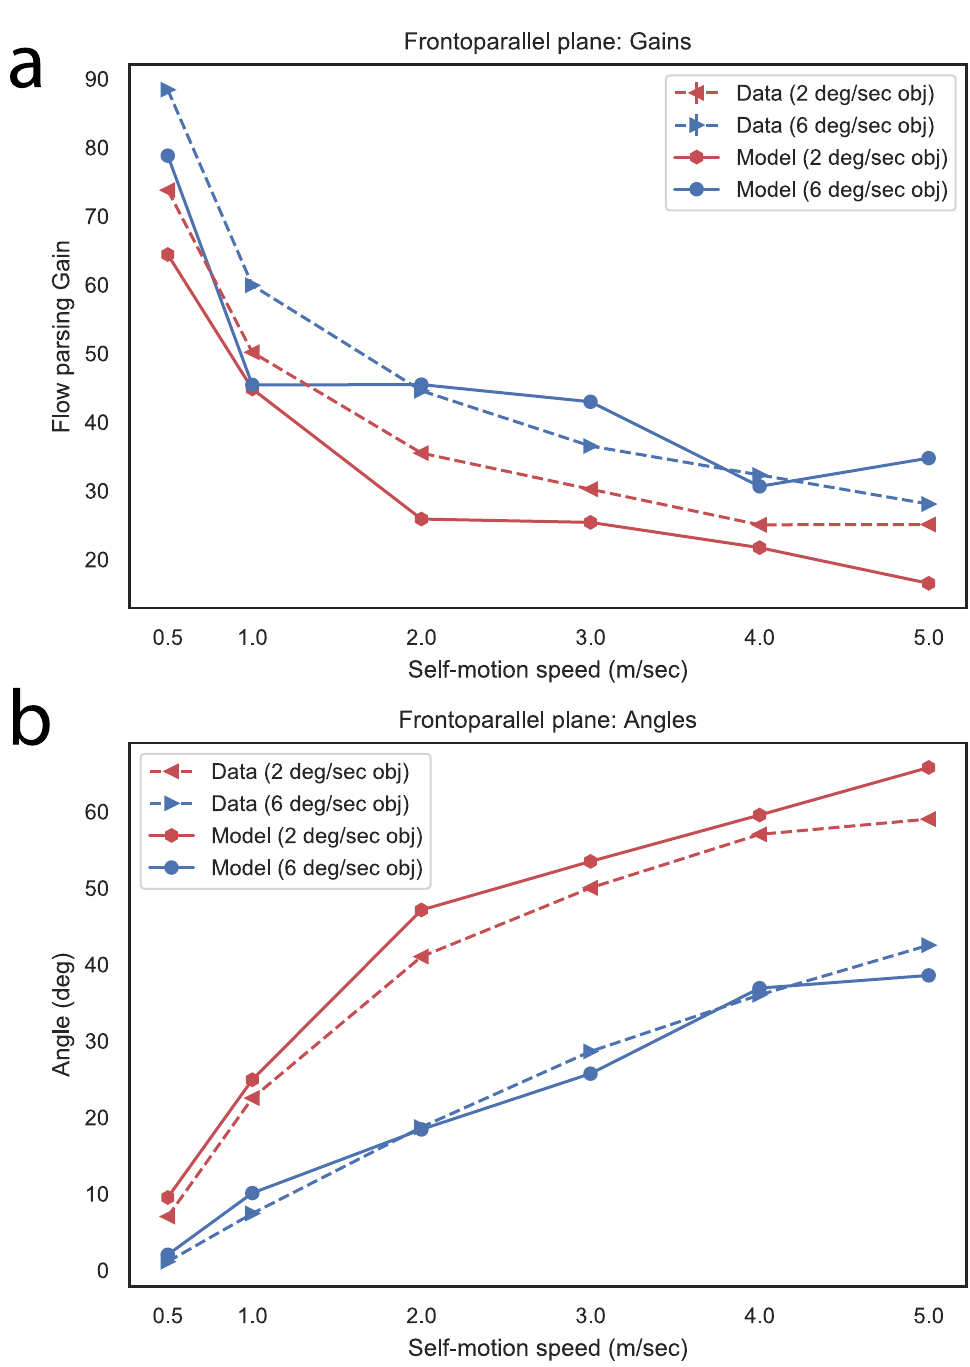
Fig 5. (a) The accuracy of human object motion judgments in Simulation 1 (frontoparallel plane), as measured by flow parsing gain (reproduced from Niehorster, 2013), compared with model object direction estimates. (b) Human judgments and model object direction estimates compared, expressed as angles. 0˚ indicates the retinal object direction and positive angles indicate shifts toward the world-relative direction.